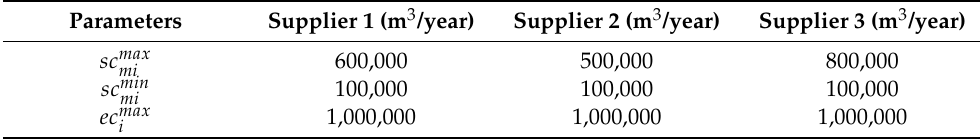
Table 5. Main parameters of suppliers.